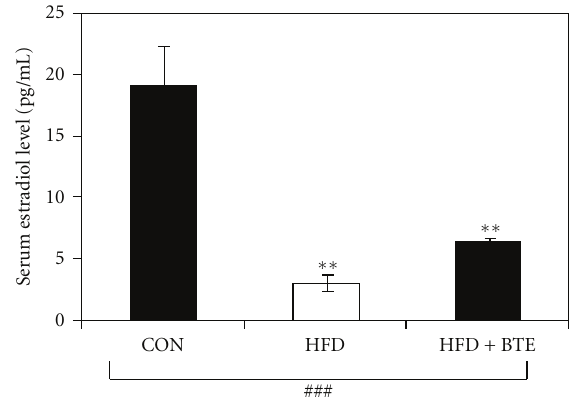
Figure 2: Serum estradiol level of control (CON; Group A), HFD treated (Group B), and HFD + BTE (Group C) supplemented female groups of rats. Values are expressed as mean ± S.E.M. ( n = 6, female data only). ### P < . 001 denotes significance level based on Kruskal-Wallis nonparametric ANOVA test and ∗∗ P < . 01 denotes significance level based on Mann-Whitney “U” multiple comparison